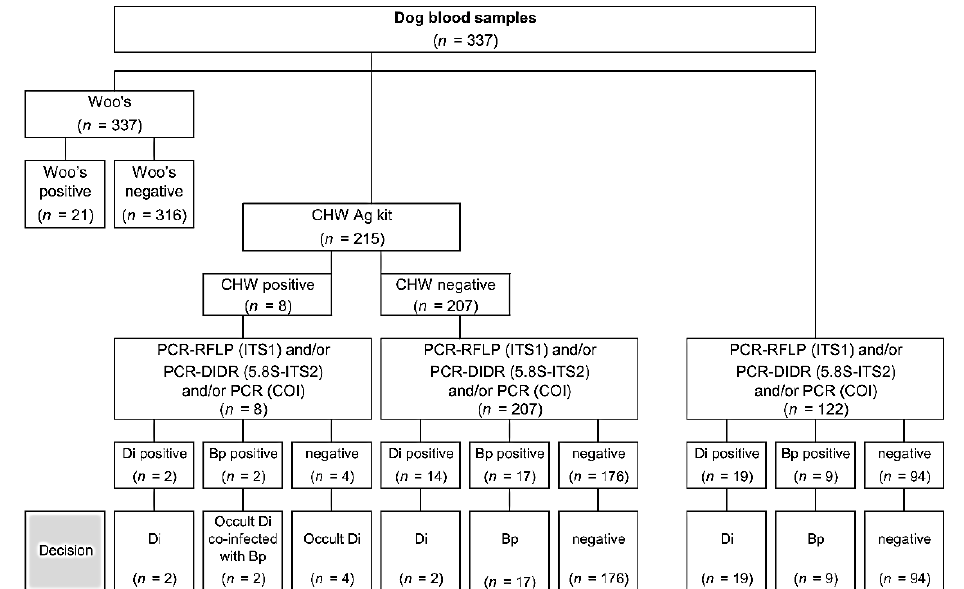
Figure 2. Diagnostic diagram of canine filariasis using CHW Ag test kit and three molecular techniques: PCR-RFLP of ITS1 region, PCR of 5.8S-ITS2-28S region, and PCR of cox 1 gene. Di: D. immitis ; Bp: Brugia pahangi .